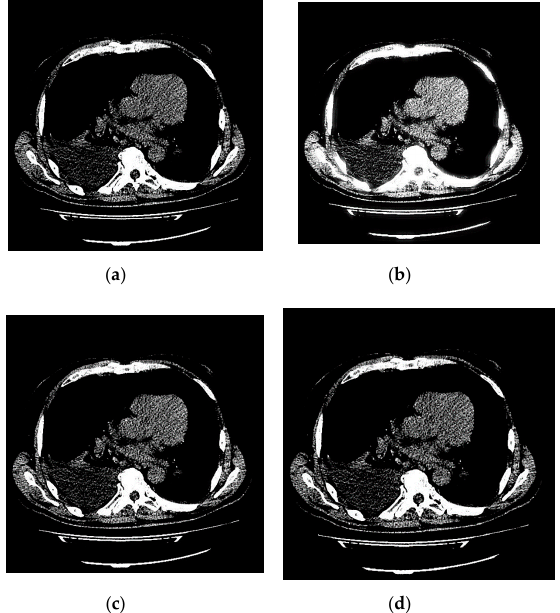
Figure 7. Example of 3D tomographic 16-bit image “Body_1.0” (1-st frame) DWT by db 8 wavelet: ( a ) original image; processed image: ( b ) r = 7, PSNR = 64.05 dB; ( c ) r = 10, PSNR = 85.30 dB and ( d ) r = 17, PSNR = ∞